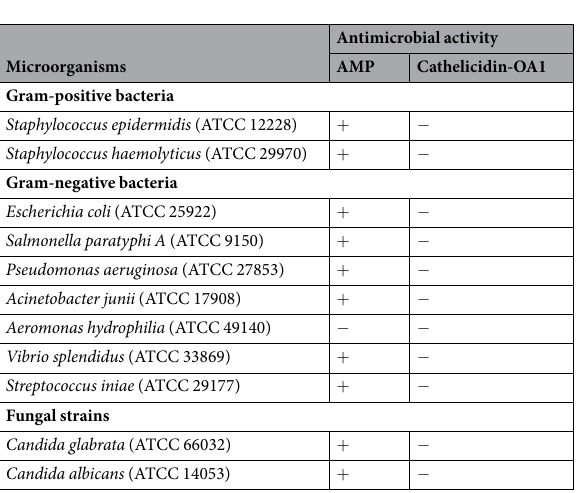
Figure 4. Free radical scavenging activities of cathelicidin-OA1. ( A ) Dose-dependent ABTS + free radical scavenging activity of cathelicidin-OA1. ( B ) Dose-dependent DPPH free radical scavenging activity of cathelicidin-OA1. ‘H 2 O’ indicates negative control and ‘vitamin C’ indicates positive control. * P < 0.05, ** P < 0.01, and *** P < 0.0001 indicate significant differences from the negative control (Students t -test). Data are mean values of three independent experiments performed in triplicate.